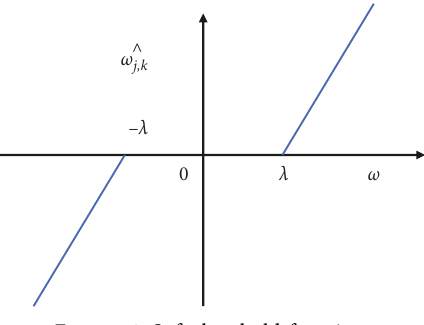
Figure 4: Soft threshold function.